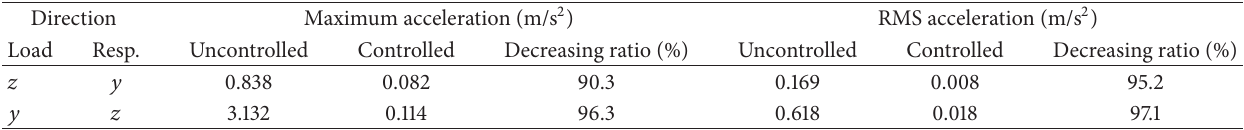
Table 8: Directional results for El Centro earthquake.